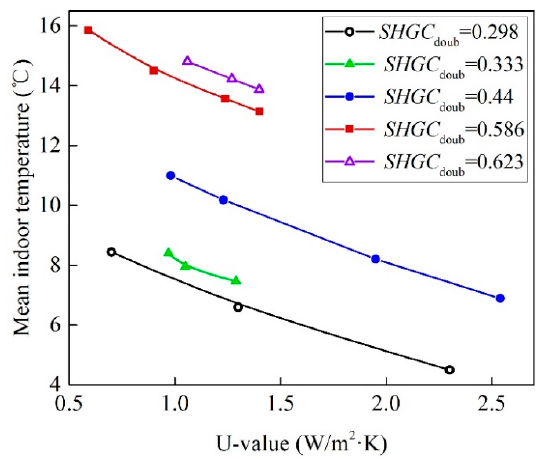
Figure 16. Mean indoor air temperature for various U-values of double-glass window.